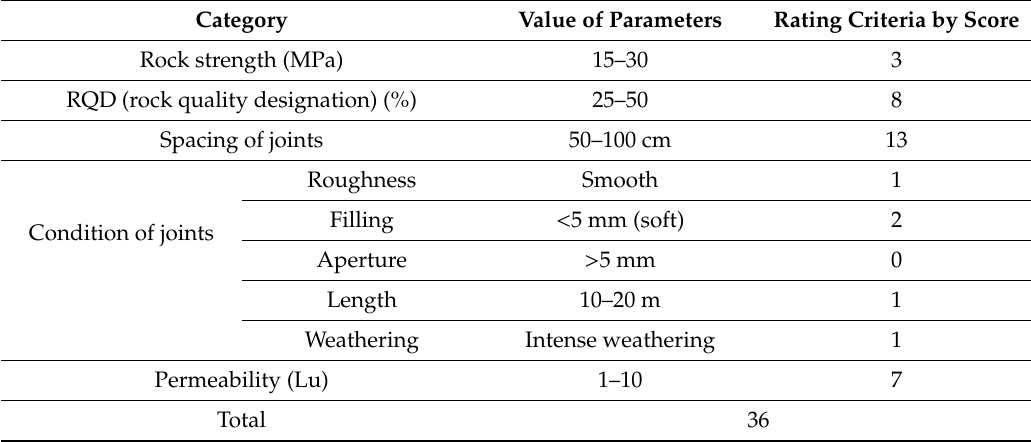
Table 4. Classification parameters of RMR (rock mass rating) for the Daoxu slope.